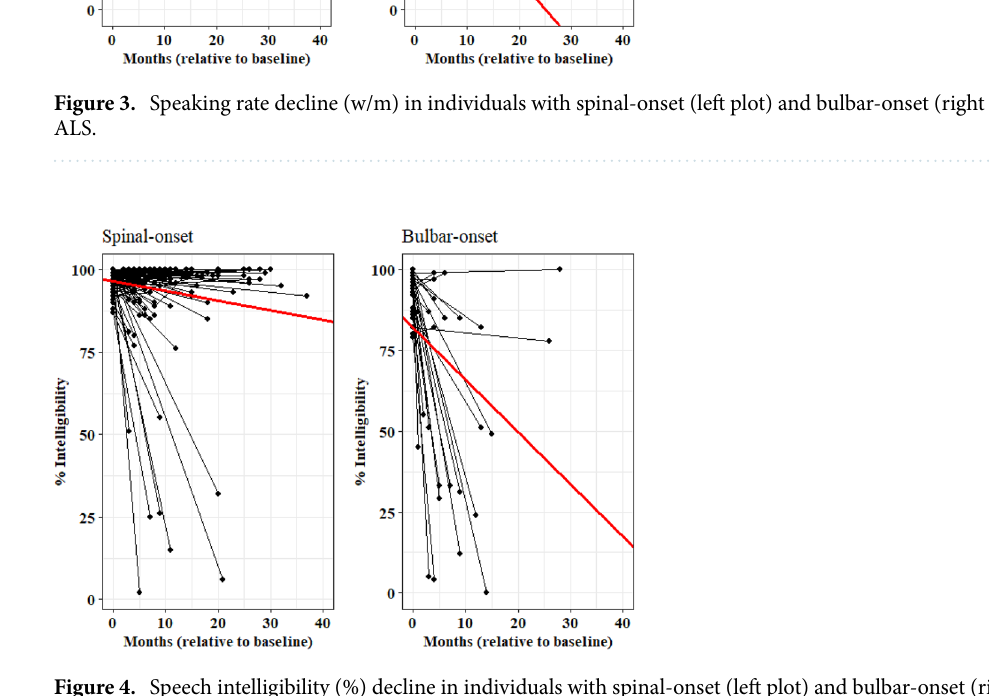
Figure 4. Speech intelligibility (%) decline in individuals with spinal-onset (left plot) and bulbar-onset (right plot)